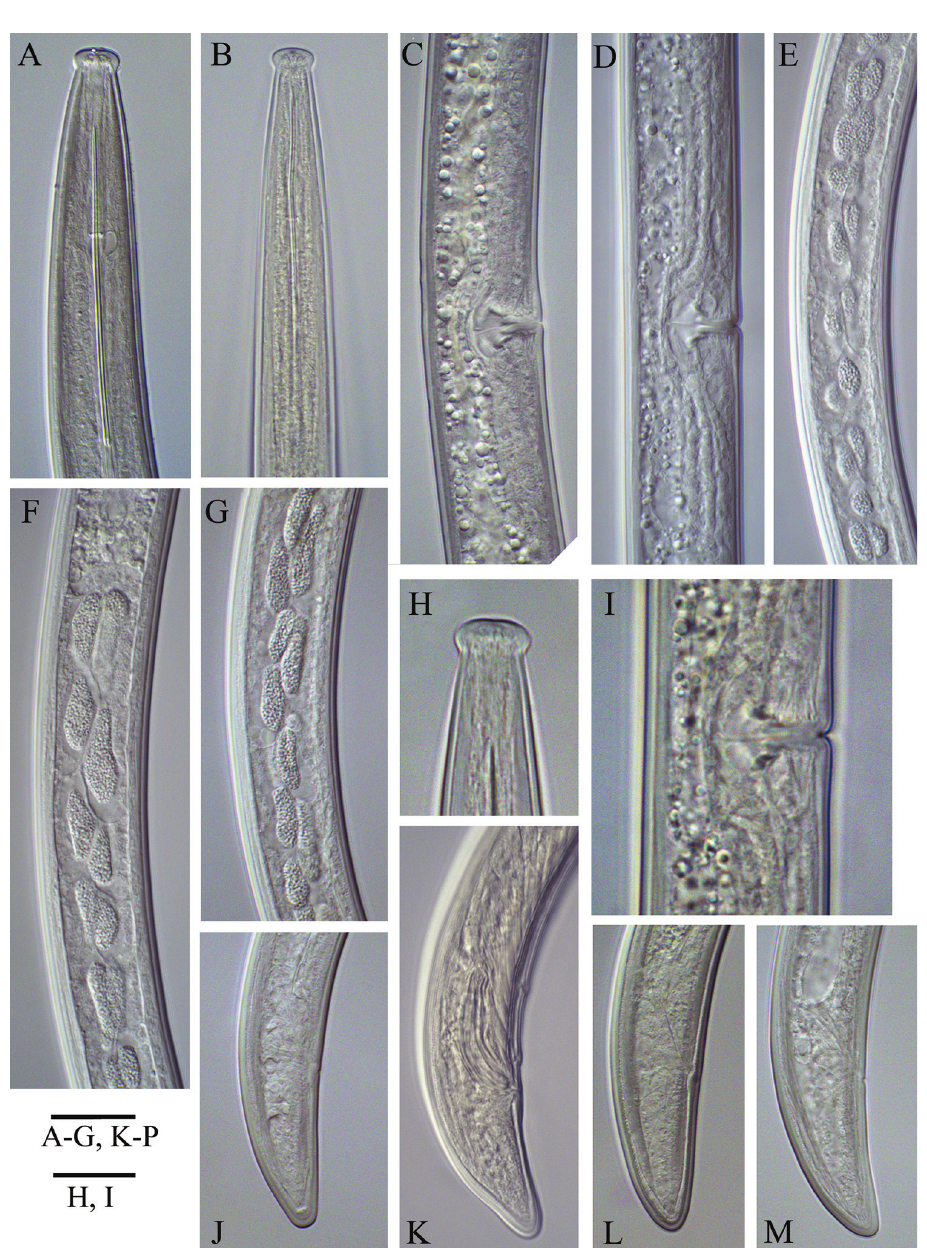
Figure 8. Bulgarian populations of Longidorus pisi Edward, Misra & Singh, 1964, anterior end of female ( A ) and male ( B ) female C, D vagina and part of reproductive system (different populations) E–G pre- rectum inclusions H labial region I vagina J–M variations in tail shape, female ( J, L, M ) and male ( K ). Populations: A, L Petrich C, E–G, M Sandanski D, H, I, J Kromidovo B, K male specimens from a tobacco field, Petrich region. Scale bars: 20 μm ( A–G, J–M ); 12 μm ( H, I